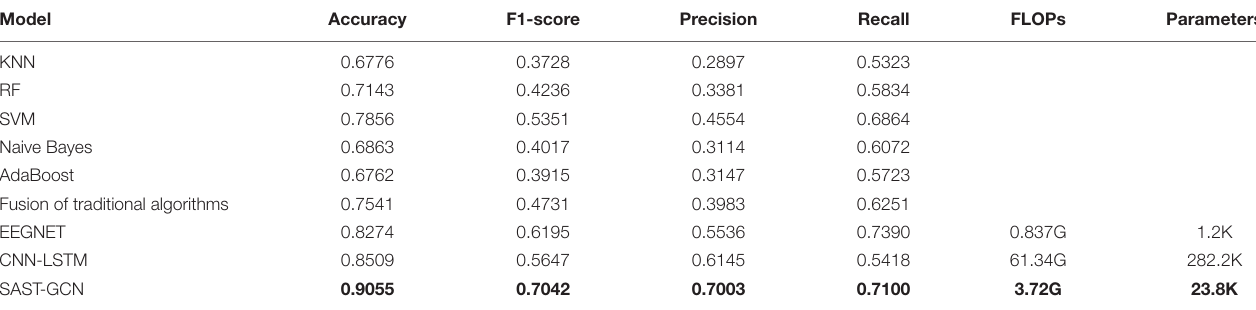
TABLE 2 | The accuracy, F1-score, precision, recall and complexity of different methods. Model Accuracy F1-score Precision Recall FLOPs